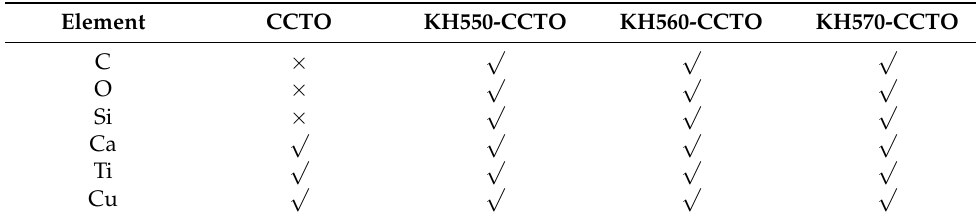
Table 1. List of elements contained in the unmodified CCTO and modified CCTO. Element CCTO KH550-CCTO KH560-CCTO KH570-CCTO